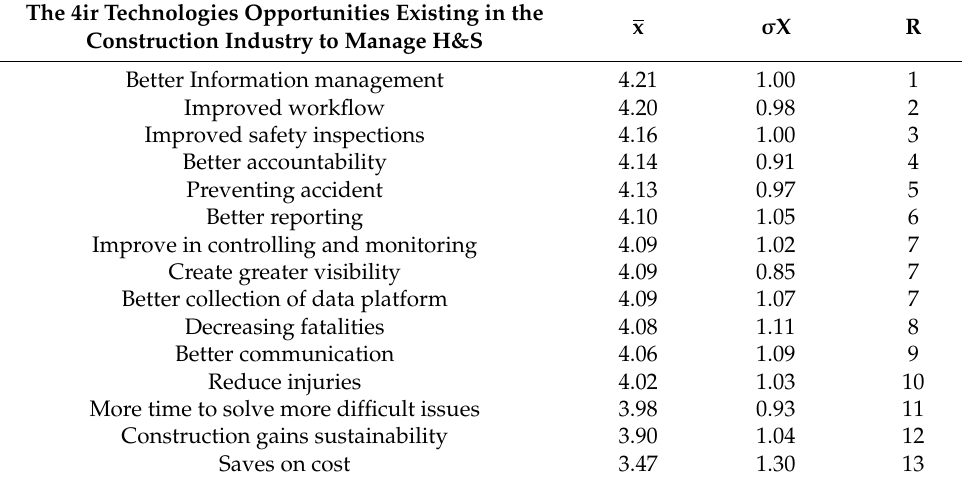
Table 2. Existing Opportunities.